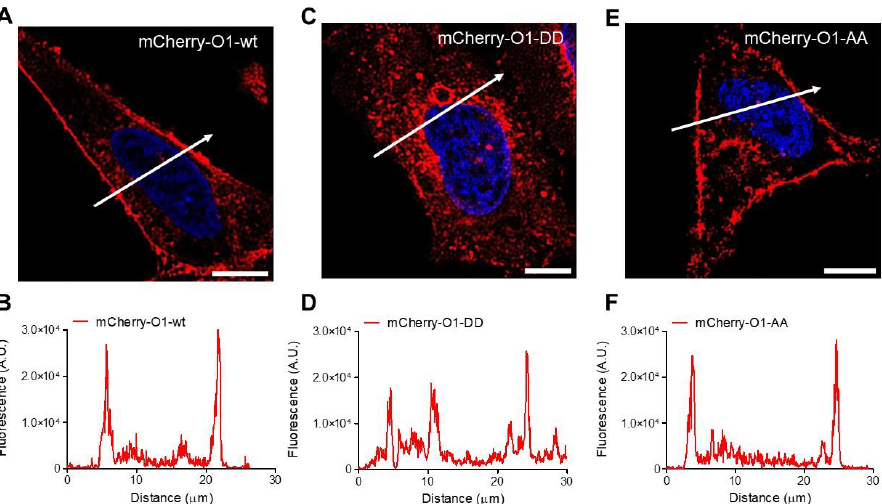
Figure 5. Cellular distribution of the different O1 channels in HeLa cells. Representative fluorescence micrographs for cells in resting conditions expressing mCherry-O1-wt ( A ), mCherry-O1-DD mutant ( C ), or mCherry-O1-AA mutants ( E ). White bars represent 10 m. White arrows indicate the cell region used to obtain the fluorescence amplitude profile for mCherry-O1-wt ( B ), mCherry-O1-DD ( D ), or mCherry-O1-AA ( F ). Although all Orai channels displayed a certain level of internaliza- tion, the internal distribution was the largest in mCherry-O1-DD.